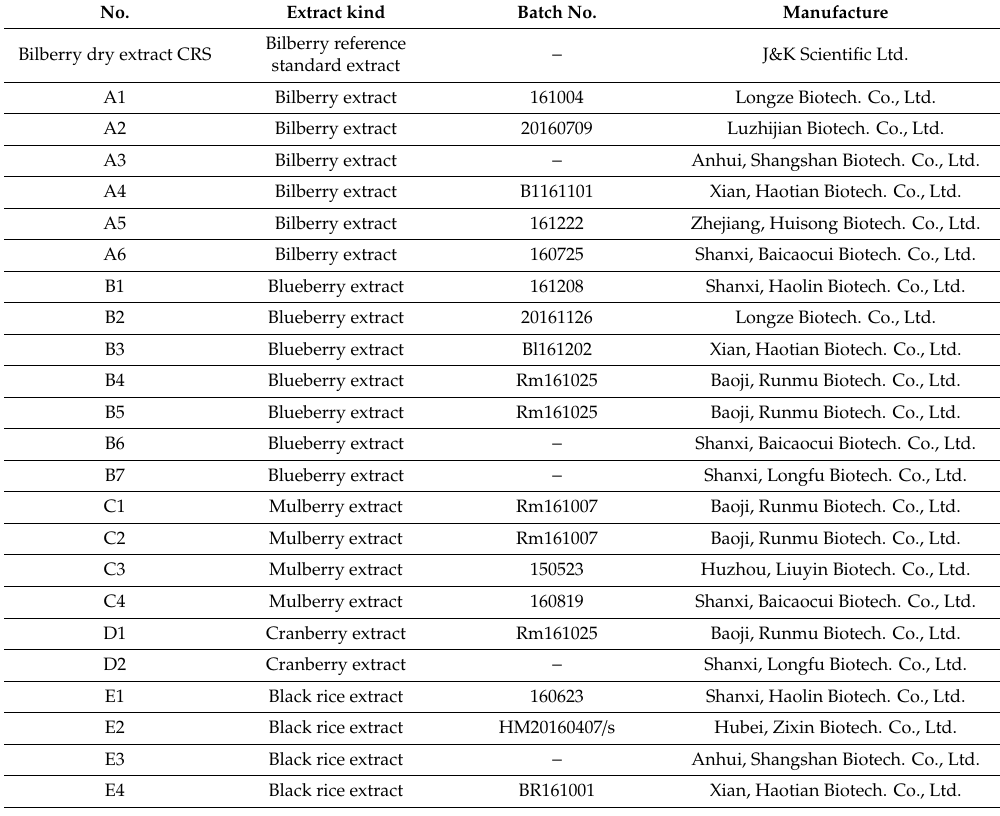
Table 6. Information about the extract